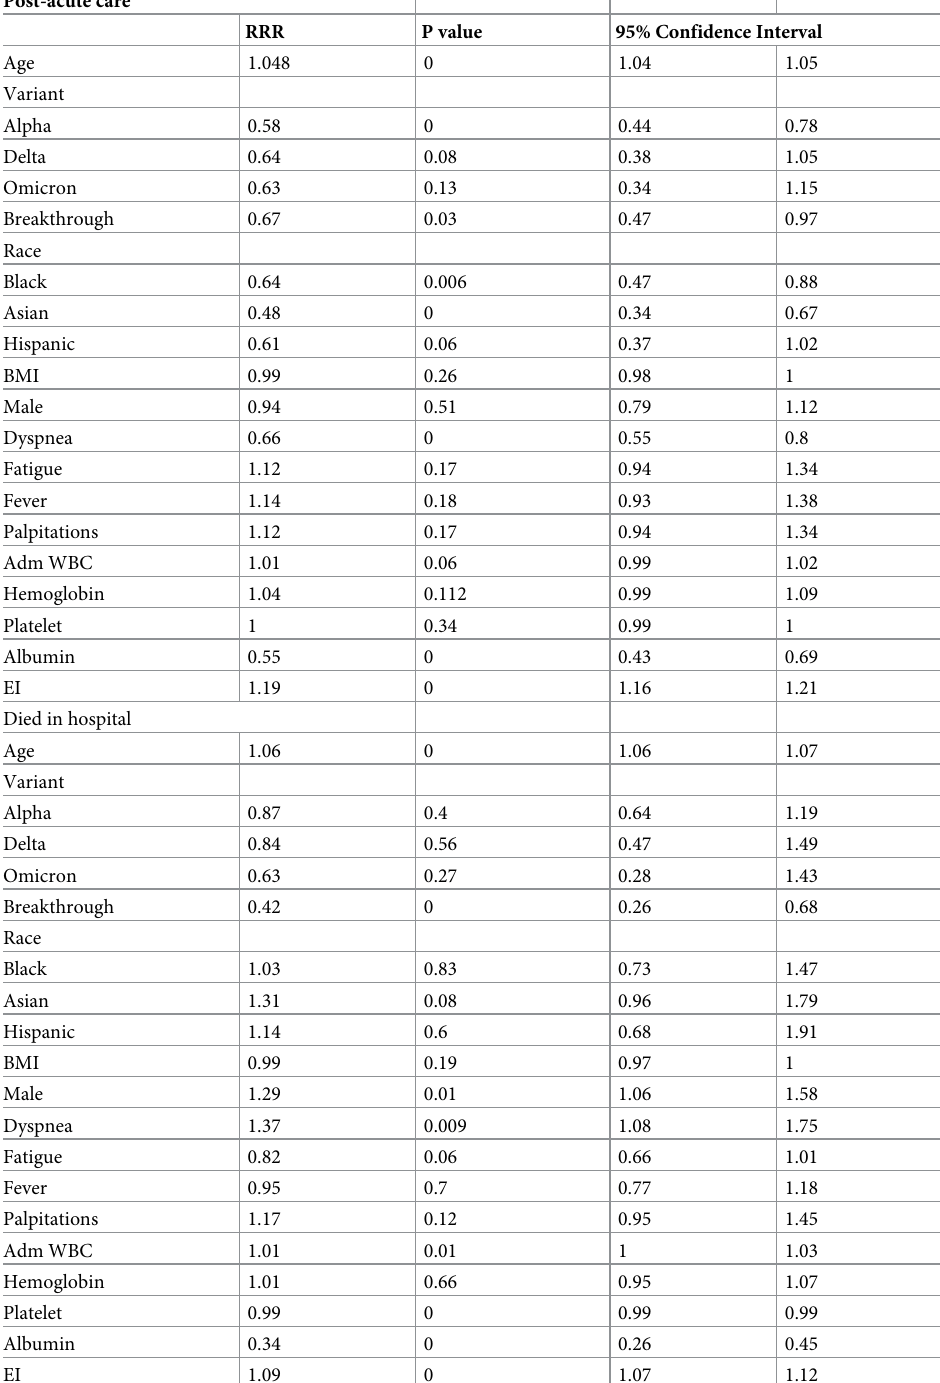
Table 4. Multinomial logistic regression of discharge dispositions i.e., post-acute care or died in hospital with the base outcome for comparison being